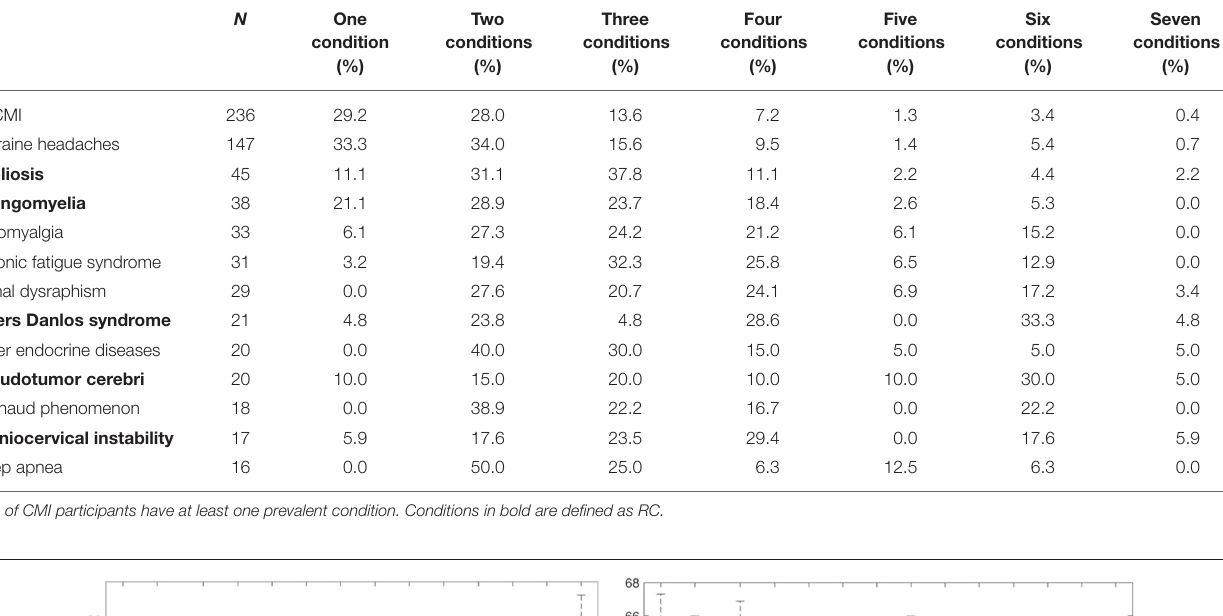
Fibromyalgia and CFS CMI participants with Fibromyalgia and CFS demonstrated similar morphometric differences from controls, including a smaller pons height. A significantly smaller Wackenheim angle and a significantly larger Boogard angle were identified for both fibromyalgia and CFS participants. Morphometric